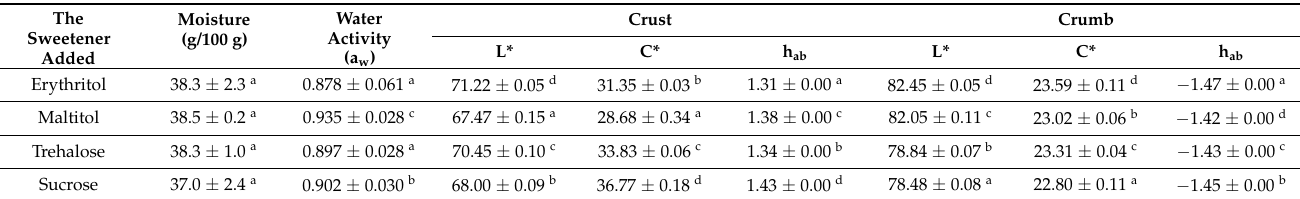
Table 2. Physicochemical parameters of sponge cakes with sweetener (each value is presented as mean ± SD; values with the same letter in a column are not significantly different at a p < 0.05